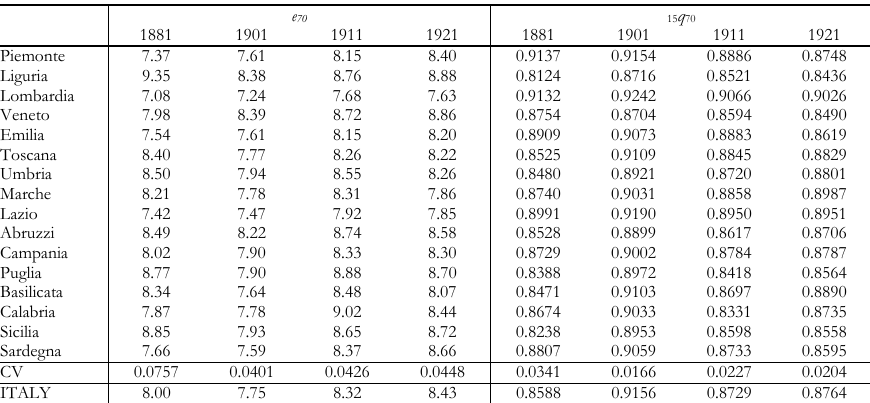
Regional life tables (both sexes): life expectancy at 70 years of age and probablility of dying between 70 and 85